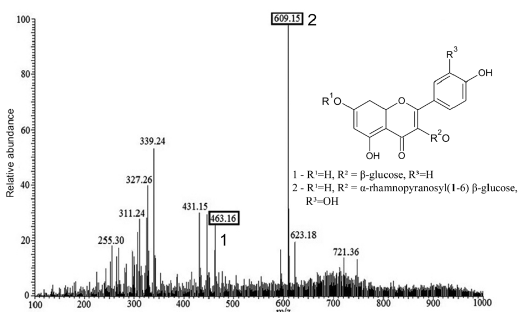
Figure 9: MS-ESI of methanolic Bauhinia purpurea extracts and chemical structure of isoquercetrin (1) and rutin (2).